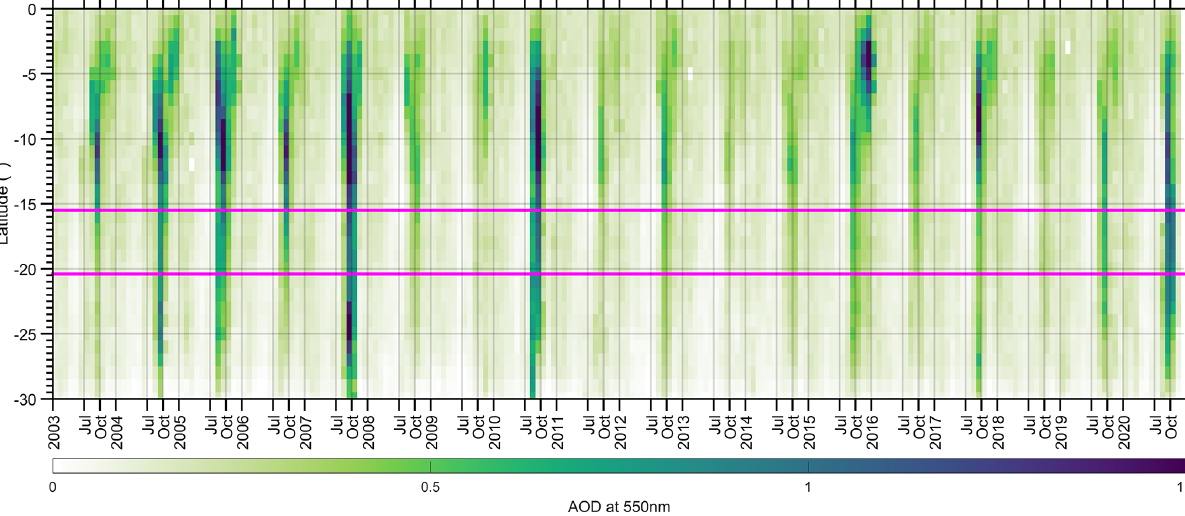
Figure 3. Hovmöller diagram of mean AOD at 550nm from the Amazon Rainforest latitudes to the Pantanal downwind regions, considering the average between the Pantanal borders at western (58.5 ◦ W) and eastern (54.96 ◦ W) longitudes (see Fig. 1). The magenta line represents the northern and southern limits of Pantanal. Each year’s label is defined at its beginning, 1 January, also the case for the months of July and October, which is used to highlight the biomass burning season